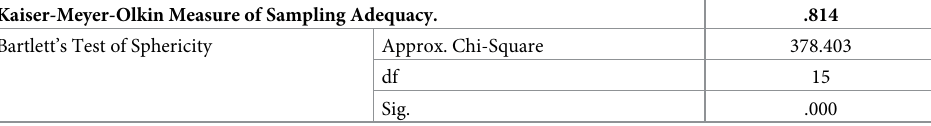
Table 4. KMO test of sample adequacy based on correlation. Kaiser-Meyer-Olkin Measure of Sampling Adequacy.